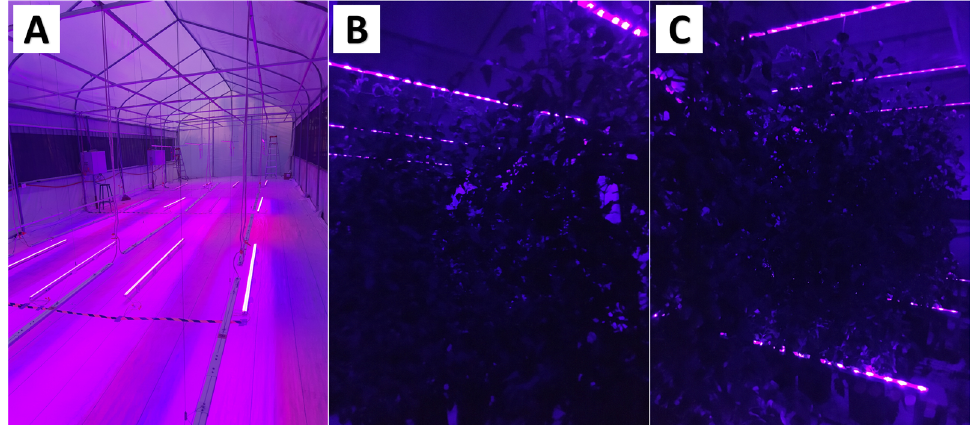
Figure 1. Greenhouse used for the experiment ( A ), and the application of treatments with supple- mentation of UV-A radiation via one lamp ( B ) and two lamps ( C